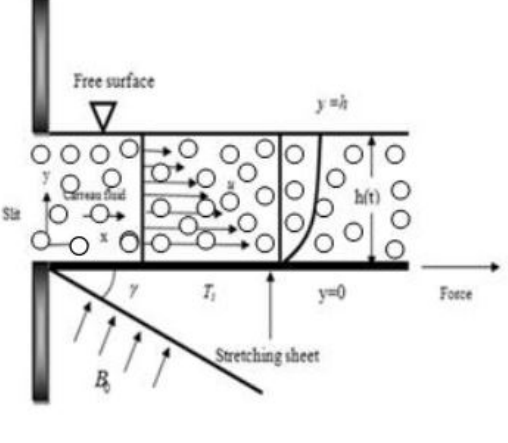
Figure 1. Flow geometry of the